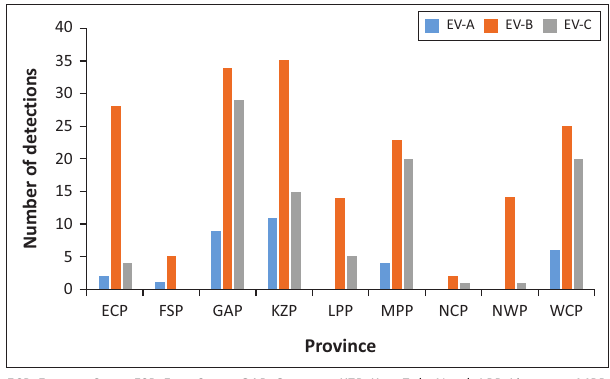
ECP, Eastern Cape; FSP, Free State; GAP, Gauteng; KZP, Kwa-Zulu Natal; LPP, Limpopo; MPP, Mpumalanga; NCP, Northern Cape; NWP, North West; WCP, Western Cape. FIGURE 2: Distribution of EV-A, EV-B and EV-C per province in South Africa.